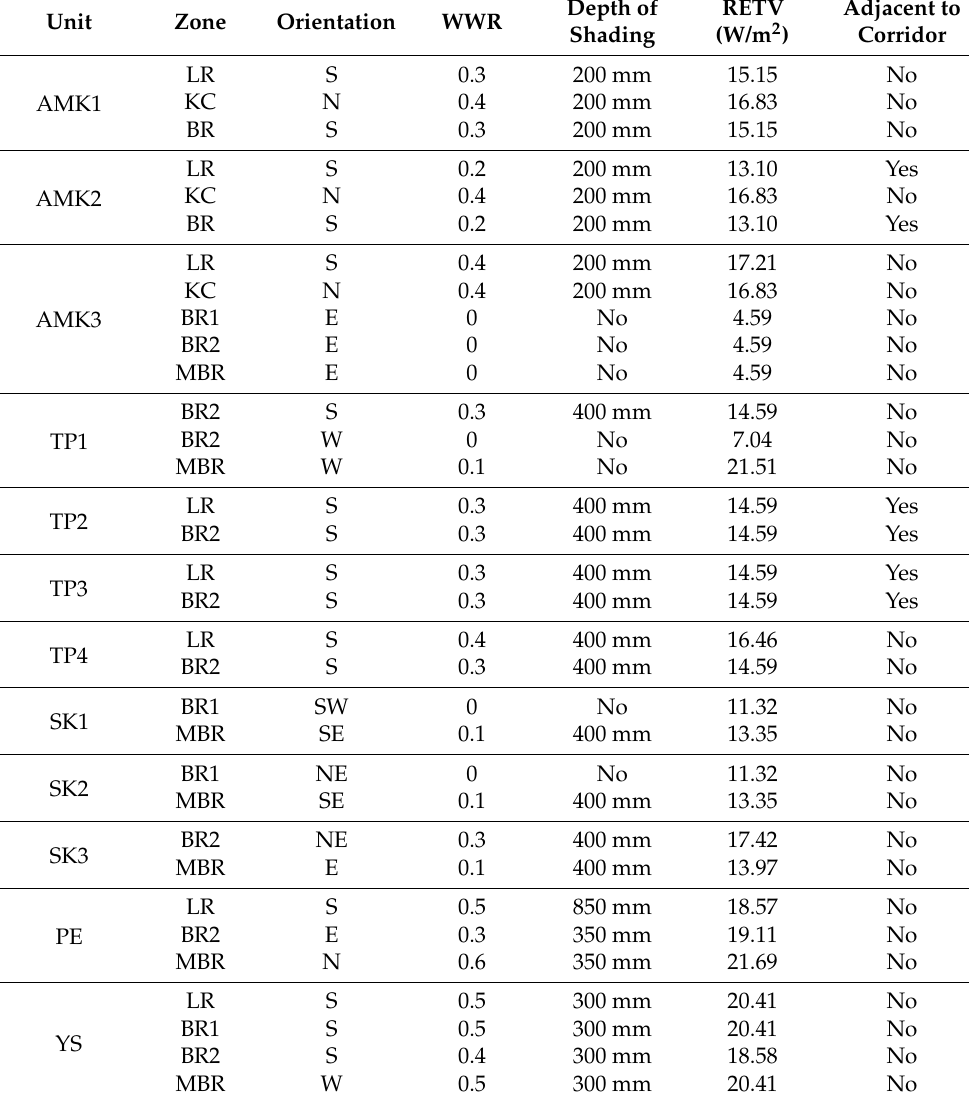
Table 3. Façade design parameters of the target